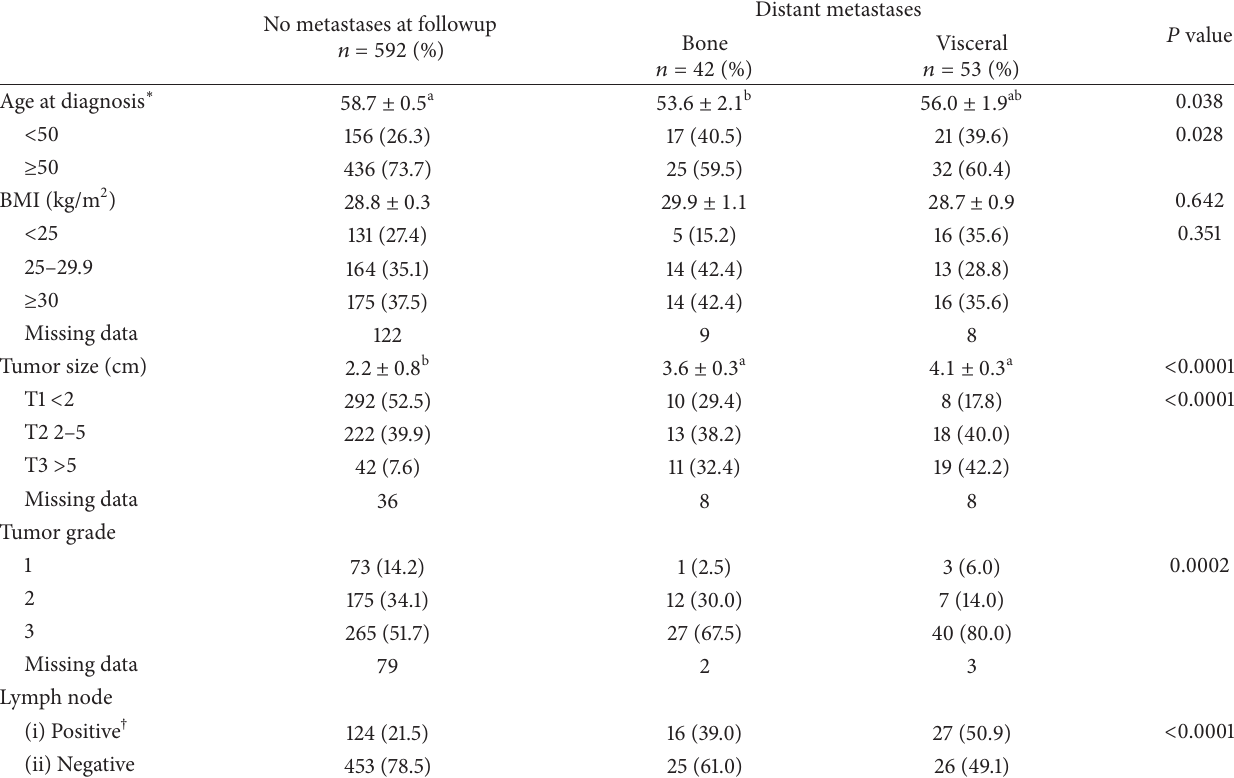
Table 1: Clinical features and metastatic distribution of patient population.